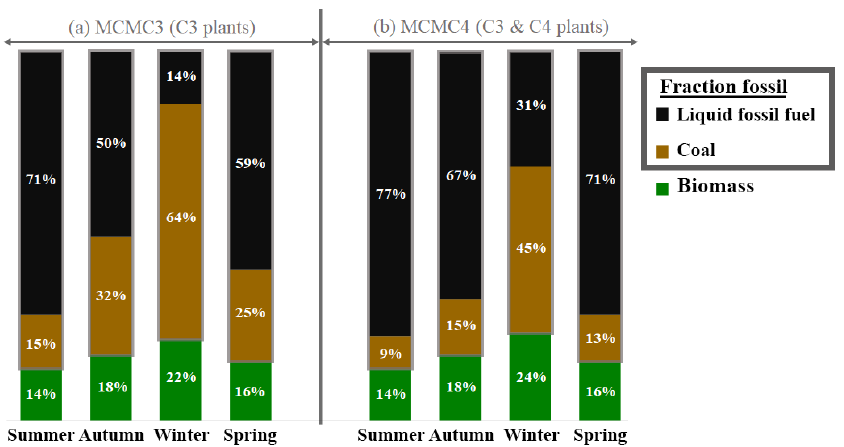
Figure 5. Sources of EC in different seasons. Results from the F 14 C- and δ 13 C-based Bayesian source apportionment calculations of EC. The numbers in the bars represent the median contribution of liquid fossil fuel, coal, and biomass burning. (a) Results from the MCMC3 model, including C 3 plants as biomass, coal, and liquid fossil fuel. (b) Impact of C 4 plants burning on EC source apportionment is tested by including C 4 biomass in the calculations (MCMC4). Including C 4 plants in the calculations does not affect the contribution of biomass burning to EC. The relative fraction of C 3 and C 4 plants in biomass burning is shown in Fig. S10. In winter, the sample taken on Chinese New Year’s Eve (25 January 2009) was